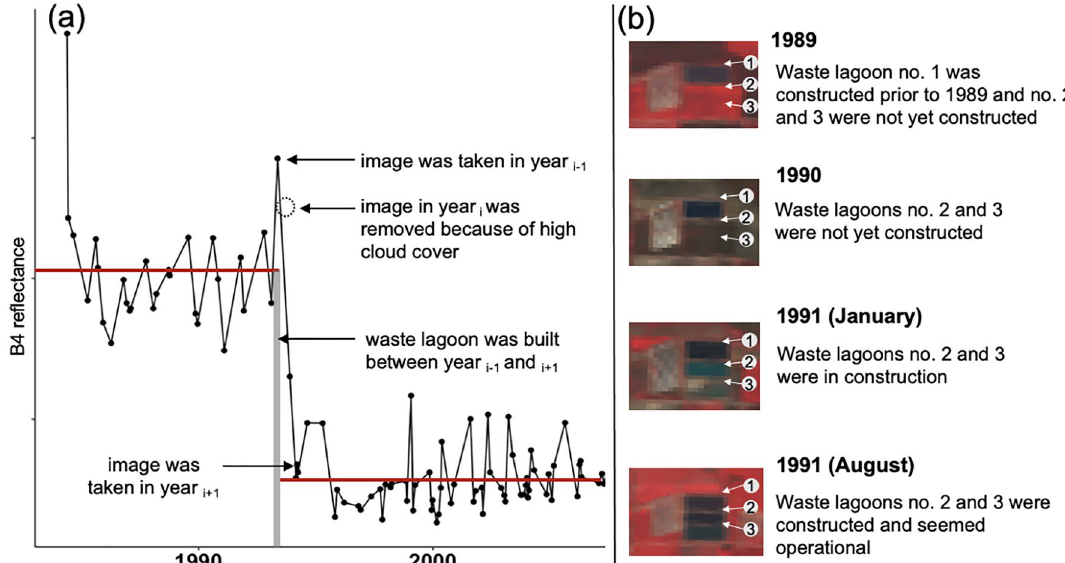
Figure 5. Examples of limitations to the changepoint detection algorithm. In some cases, an insufficient number of high-quality Landsat 5 images were available to capture the year of construction of an individual swine waste lagoon ( a ), resulting in errors of + /− 1 year. In other cases, the changepoint algorithms detected the start of the construction of the swine waste lagoon but the swine waste lagoon was not fully operational until later years due to prolonged construction timelines ( b ).